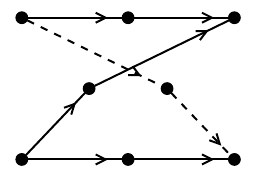
Figure 23: The second Heuchenne condition.